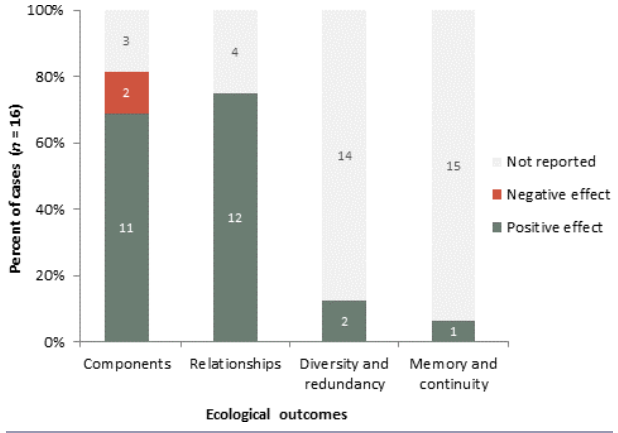
Fig. 7 . Percent of cases that reported positive and negative ecological outcomes. The total number of cases assessed was 16 (two cases that reported mixed positive and negative outcomes were removed from this analysis). Counts in the bar graph represent the number of